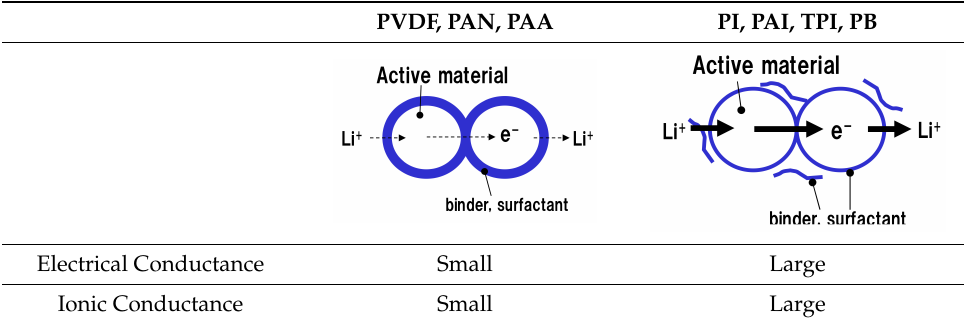
Table 1. Comparison with electrical and ionic conductance between each